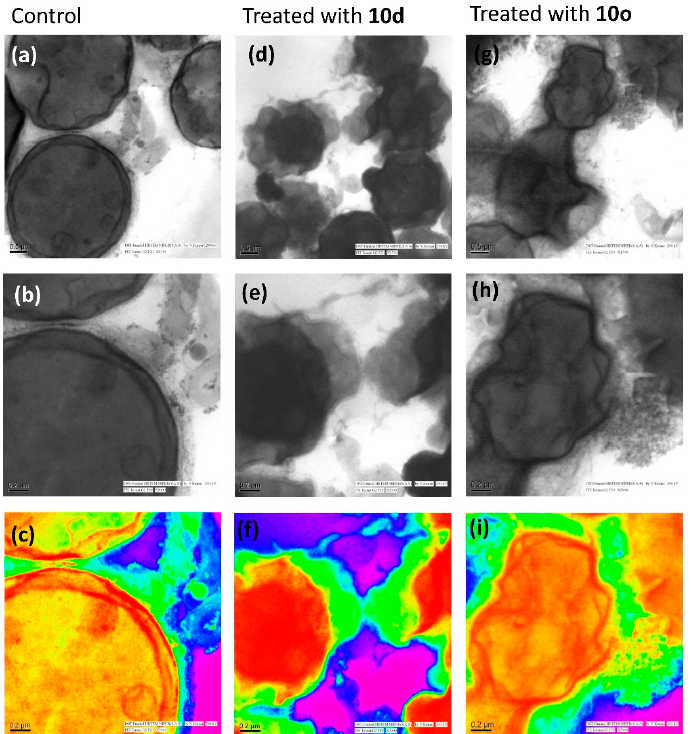
Molecules 2022 , 27 , x FOR PEER REVIEW 12 of 19 Figure 7. Morphological study of C. neoformans cells and cells treated with bioactive peptides Figure 7. Morphological study of C. neoformans cells and cells treated with bioactive peptides by by high-resolution transmission electron microscopy. Images ( a – c ) represent the morphology of high-resolution transmission electron microscopy. Images ( a – c ) represent the morphology of un- treated/healthy cells; images ( d – f ) represent the cells treated with 10d and images ( g – i ) represent untreated/healthy cells; images ( d – f ) represent the cells treated with 10d and images ( g – i ) represent the cells treated with 10o ; images ( c , f , i ) are the rainbow form of images ( b , e , h ), respectively. The 10o (Figure 8e,f) were highly deformed and shrunken. The membrane separating the cells the cells treated with 10o ; images ( c , f , i ) are the rainbow form of images ( b , e , h ), respectively. The scale scale bar for images ( a , d , e ) is 0.5 μ m and for images ( b , c , e , f , h , i ) it is 0.2 μ m. seemed to have disappeared and merged to form a cluster of deformed cells. bar for images ( a , d , e ) is 0.5 µ m and for images ( b , c , e , f , h , i ) it is 0.2 µ m. Scanning transmission electron microscopy (STEM) analysis provides high contrast images of the cells and the results were in coherence with the HRTEM. The STEM images of untreated cells (Figure 8a,b) depict smooth walled, rounded cells with cell organelles intact, whereas the images of cells treated with peptide 10d (Figure 8c,d) show highly shrunken cells with irregular cell membranes. The intracellular material has oozed out and a clear distinct cell was not observed. The deformed cells have merged to appear similar to a mass of highly irregular structure. Similarly, cryptococcal cells treated with